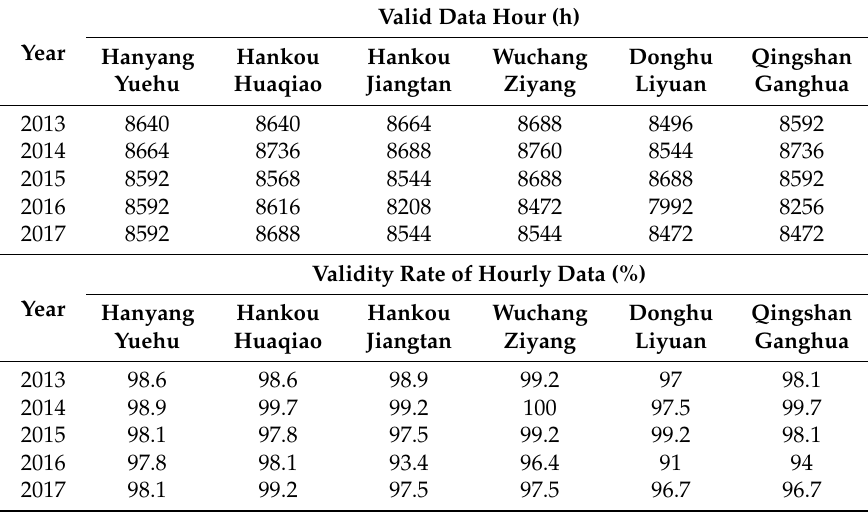
Table 2. Number of data points and validity rate for PM 2.5 monitoring data at various stations. Valid Data Hour Year